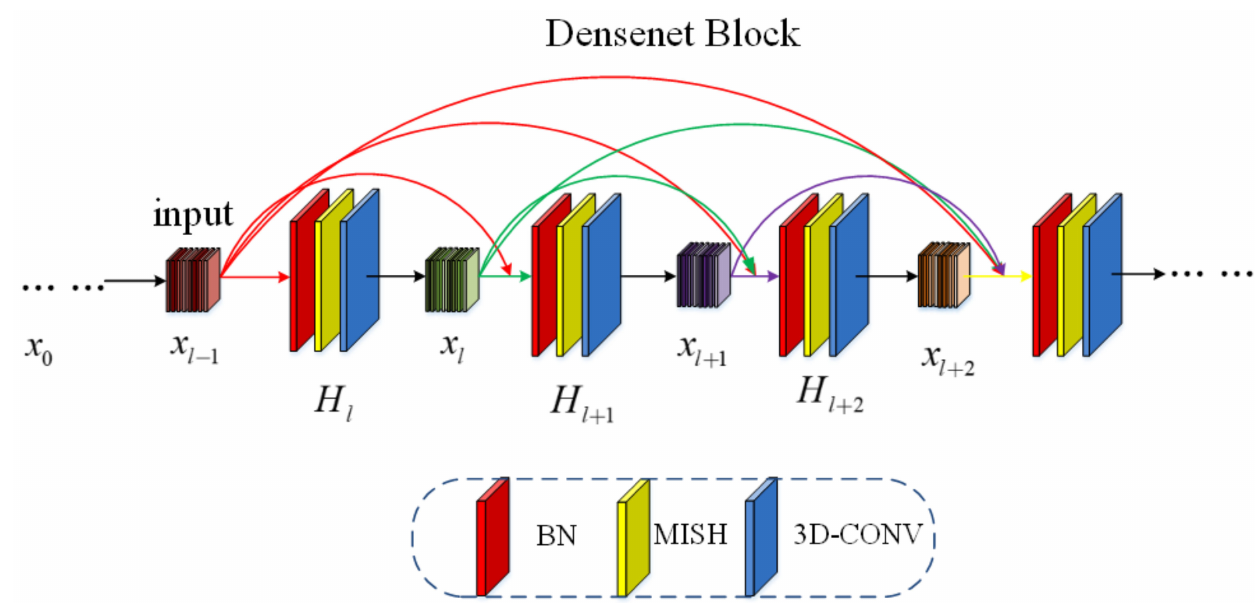
Figure 3. The schematic diagram of